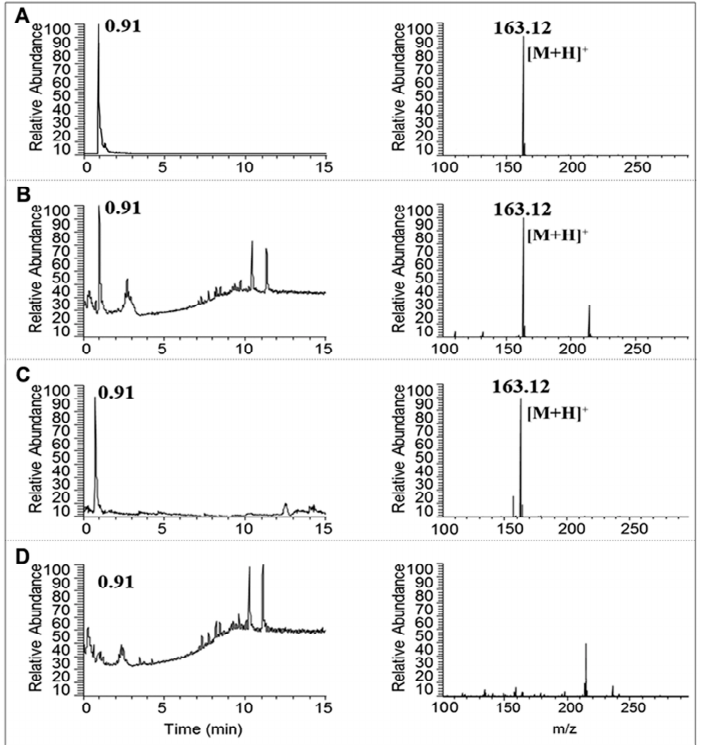
Figure 2. Chromatogram and mass spectra of nicotine in cigarette smoke extract (CSE) using ultra ‐ performance liquid chromatography tandem mass spectrometry (UPLC ‐ MS/MS). The retention time of nicotine occurs at 0.91 min (left panels), and m / z is 163.12 (right panels). ( A ) Nicotine standard, ( B ) CSE, ( C ) nicotine section of CSE (CSE ‐ N), and ( D ) nicotine ‐ free section (CSE ‐ O).